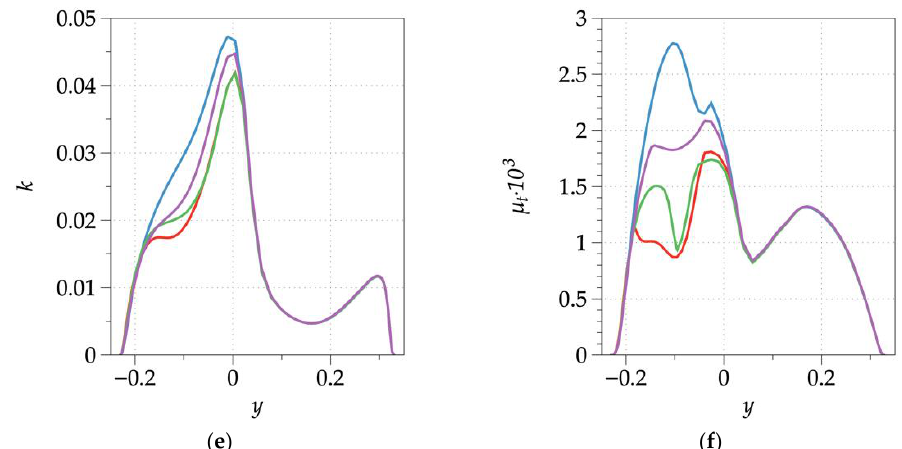
Figure 8. Profiles of the longitudinal ( a ), transverse ( b ), and vertical ( c ) Cartesian velocity components; temperature ( d ); turbulence energy ( e ); and vortex viscosity ( f ) at the central point of the conical dimples for the different standard SST models and the modified Menter SST models. Red line—Menter 1993 SST model, Blue line—Menter 2003 SST model, Green line—Menter SST model corrected according to RLI, and Purple line—Menter SST model corrected according to SM.